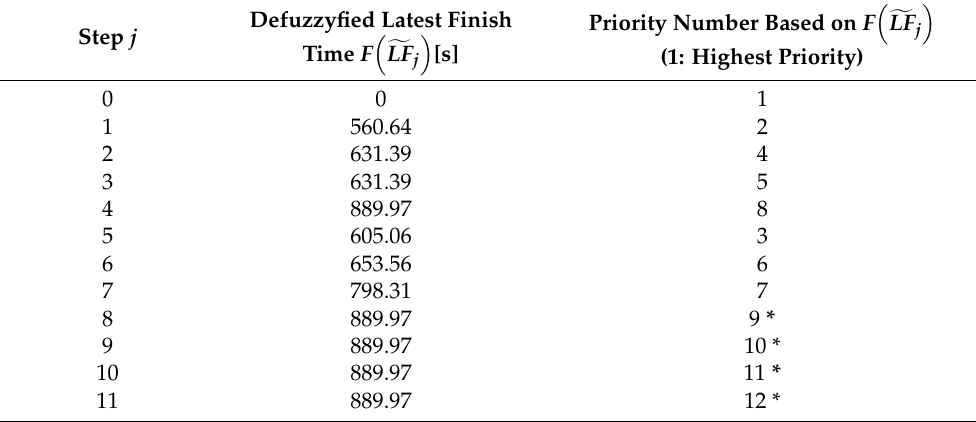
Table 6. Defuzzyfied latest finish time of disassembling steps. Step